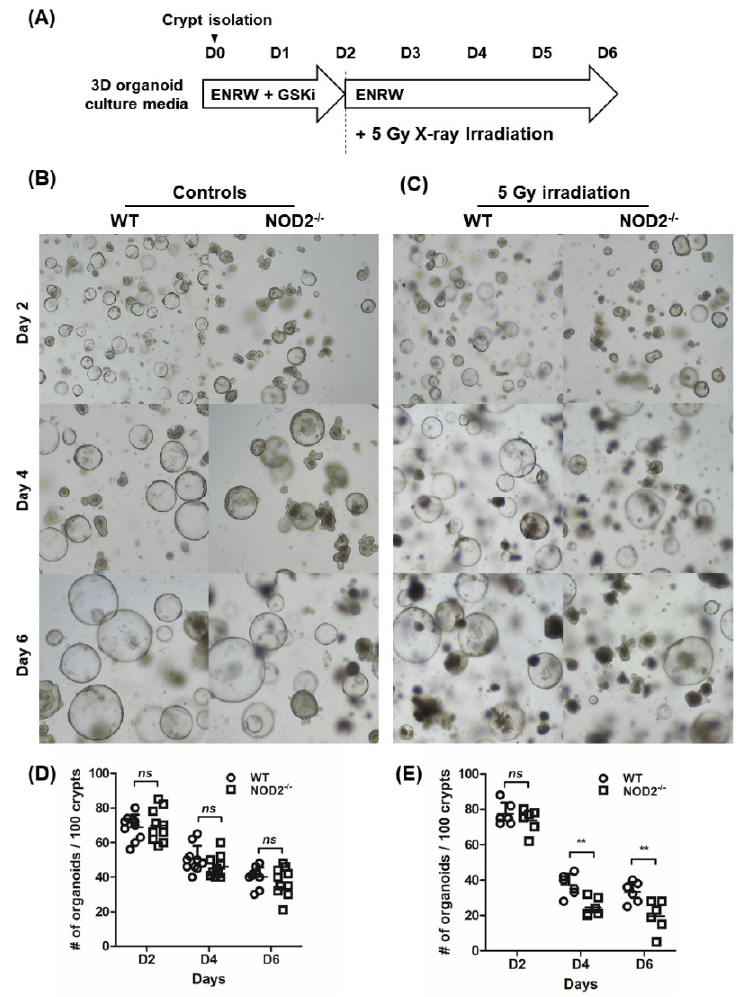
Figure 6. Organoid reconstitution assay in WT and NOD − / − mice. ( A ) Organoid reconstitution assay protocol. Micrographs of non-treated ( B ) and 5 Gy X-ray-irradiated ( C ) organoids. The number of viable organoids per well in non-treated ( D ) and 5 Gy X-ray-irradiated (E) organoids. All differences were evaluated with two-way ANOVA followed by Bonferroni post-test; ** p < 0.01.